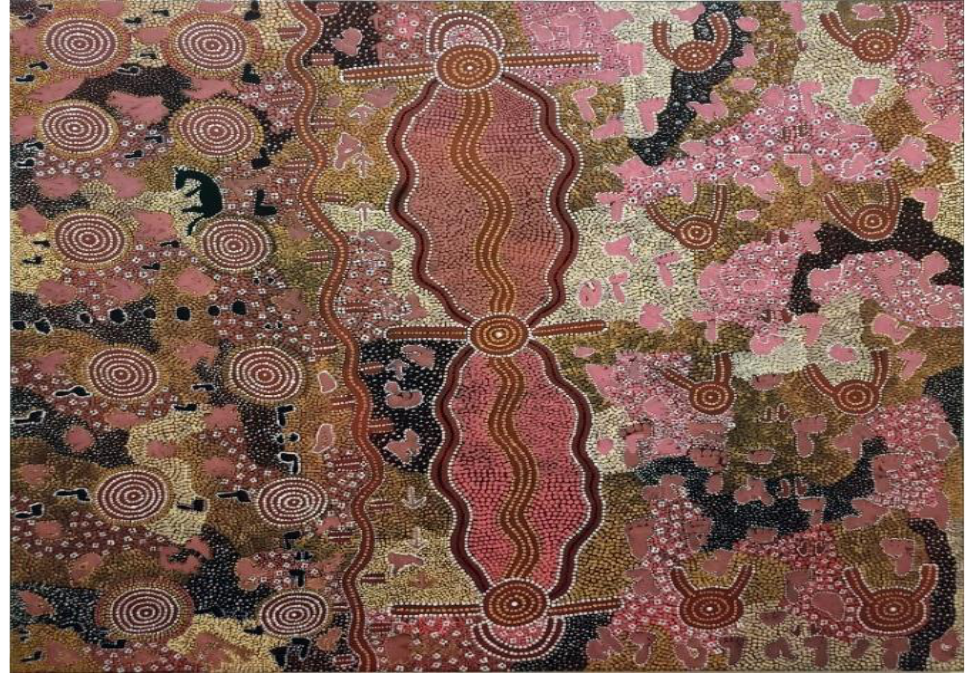
Figure 4. Dick Pantimus Tjupurrula. Water and Wallaby Dreaming, 1981. © Estate of Dick Pantimus Tjupurrula. Licensed by Aboriginal Artists Agency Ltd.